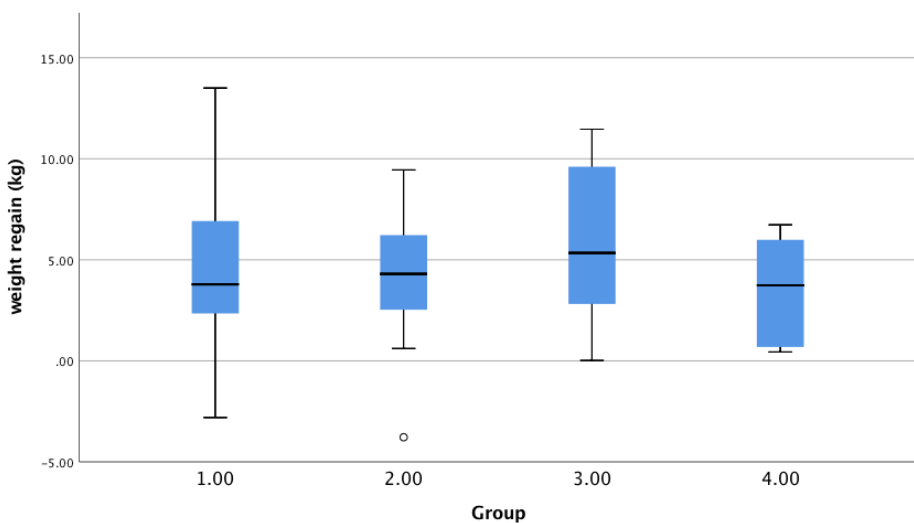
Figure 4. Weight regain in groups of subjects with different combinations of baseline FPG and CHO intake. Group 1: